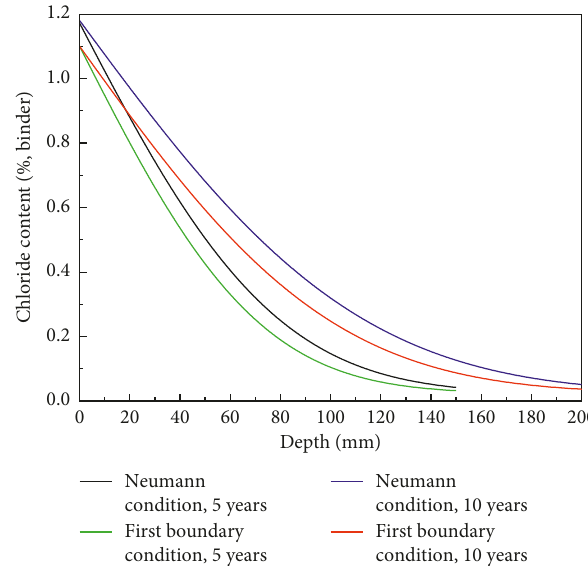
Figure 11: Long-term prediction at the age of 5 years and 10 years based on the tradition model and proposed